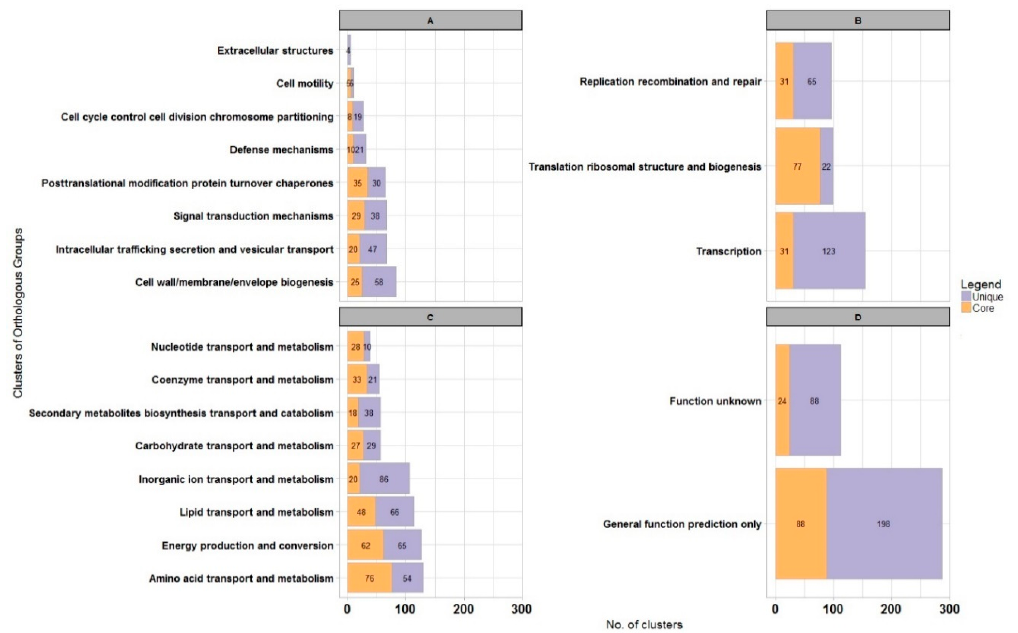
Figure 2. Genome-scale analysis of protein functions for Sphingopyxis lindanitolerans WS5A3p in context of Sphingopyxis pangenome. Bar chart illustrating protein clusters participation in different COGs functional categories for Sphingopyxis core pangenome (orange) and WS5A3p unique clusters (purple). ( A ) Cellular processes and signaling; ( B ) information storage and processing functions; ( C ) metabolism process; ( D ) unknown functions.